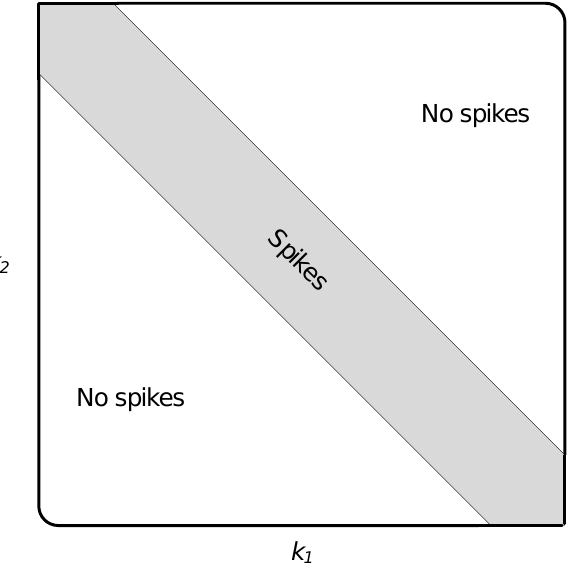
Figure 6. The architecture of a cross-correlation function when there are